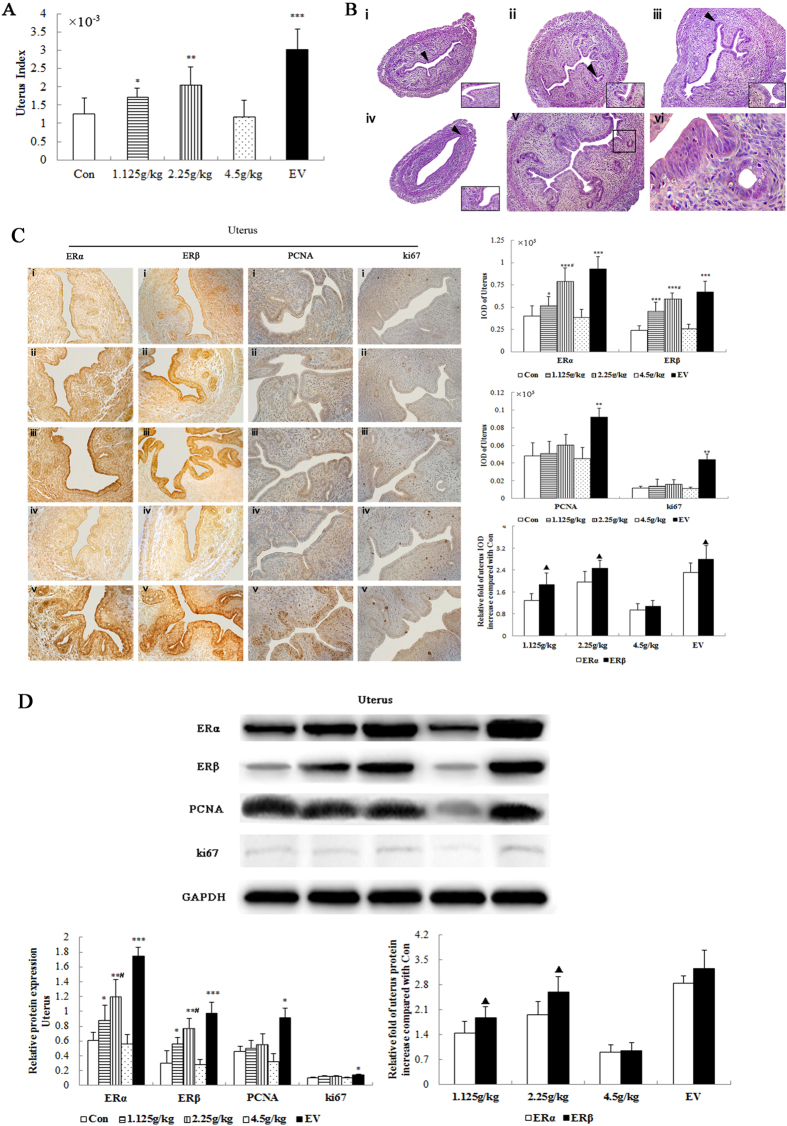
The effects of QiBaoMeiRan formula (QBMR) on uterus.Data are the mean ± standard deviation (SD) of samples from 10 mice. P values are based on the results of a one-way analysis of variance (ANOVA) comparing the treatment group to untreated immature mice. ***p < 0.001 **p < 0.01 and *p < 0.05, compared to the control group. #p < 0.05, compared with 1.125 g/kg group. (▲) p < 0.05, compared with ERα protein relative increase to Control. (A) The weights of uters were measured at the end of the 7-day treatment period. (B) The effects of QBMR treatment on the histology of the uterus in immature mice. Representative photomicrographs taken at 200× and 400× magnification. Insets (Fig. 1Bi-iv) show higher magnifications of endometrium (arrowhead). The square in (Fig. 1Bv) indicates the area shown at higher magnification in (Fig. 1Bvi). (C) The effects of QBMR treatment on the expression of the estrogen receptor (ER) α, ERβ, proliferating cell nuclear antigen (PCNA) and ki-67 antigen in the uterus. Representative photomicrographs taken at 200× magnification of ERα, ERβ expression in the uterus, 100× magnification of PCNA and ki-67 expression in uterus sections from each treatment group are shown: (i) untreated immature mice, (ii) 1.125 g/kg, (iii) 2.25 gr/kg, (iv) 4.5 g/kg QBMR, and (v) estradiol valerate (EV). (D) The effects of QBMR on the protein expression levels of estrogen receptor (ER) α, ERβ, proliferating cell nuclear antigen (PCNA) and ki-67 in the uterus by western blot and the analyses were carried out as described in the Materials and Methods.